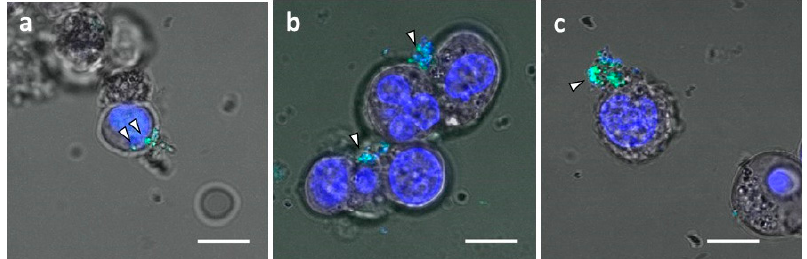
Figure 6. Inhibition of exosome uptake by endocytosis inhibitors. OPM-2-luc+ cells were treated with anti-CD63 Ab-conjugated FITC-labeled siRNA bound to branched Arg linkers. The anti-CD63 Ab-Arg linker:siRNA ratio was 2.5 :1 (750:300(nM)). ( a ) Vehicle treatment. ( b ) Latrunculin treatment (2 μ M). ( c ) Rottlerin treatment (2 μ M). Arrowheads indicate anti-CD63 Ab-conjugated FITC-labeled siRNA complexes. Scale bar, 10 μ M. Blue, Hoechst 33342 (nuclei); green, FITC-labeled siRNAs.